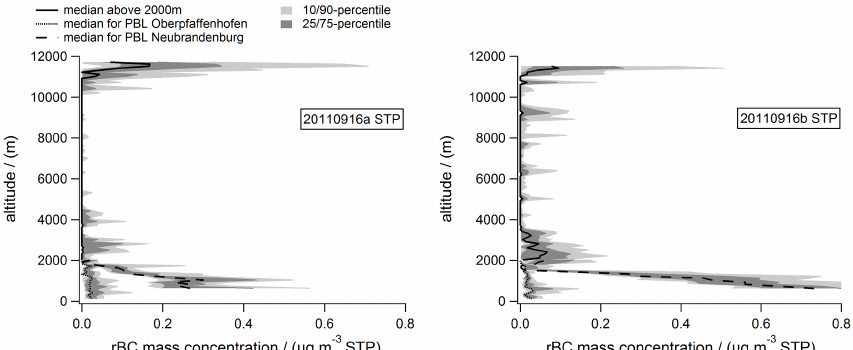
Figure 8. Vertical profiles (STP) of flight #110916a (left) and #110916b (right) on 16 September 2011 for rBC mass concentration measured with the SP2 as median (black lines), 25th/75th percentile (dark grey shading), and 10th/90th percentile (light grey shading) for 100m vertical intervals. Below 2000m the data set is split into the PBL of Oberpfaffenhofen (593ma.s.l.; dashed line) and Neubrandenburg (69ma.s.l.; dotted line). Values are representative for the approximate size range of 80–440nm for the rBC particles.